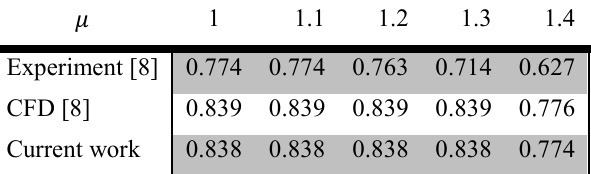
Table 2. Comparison results from Kracik [8] with current